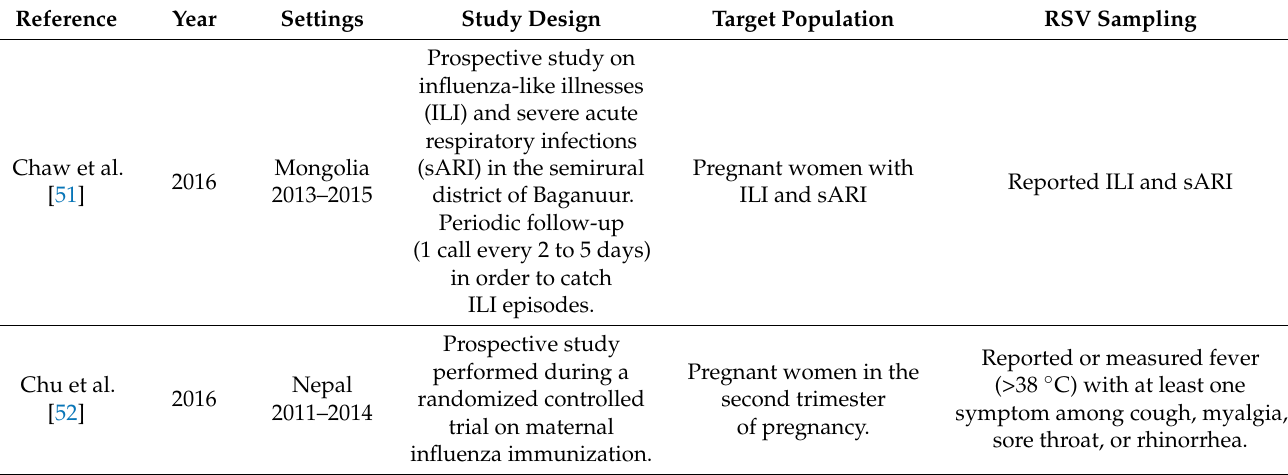
Table 1. Summary description of individual